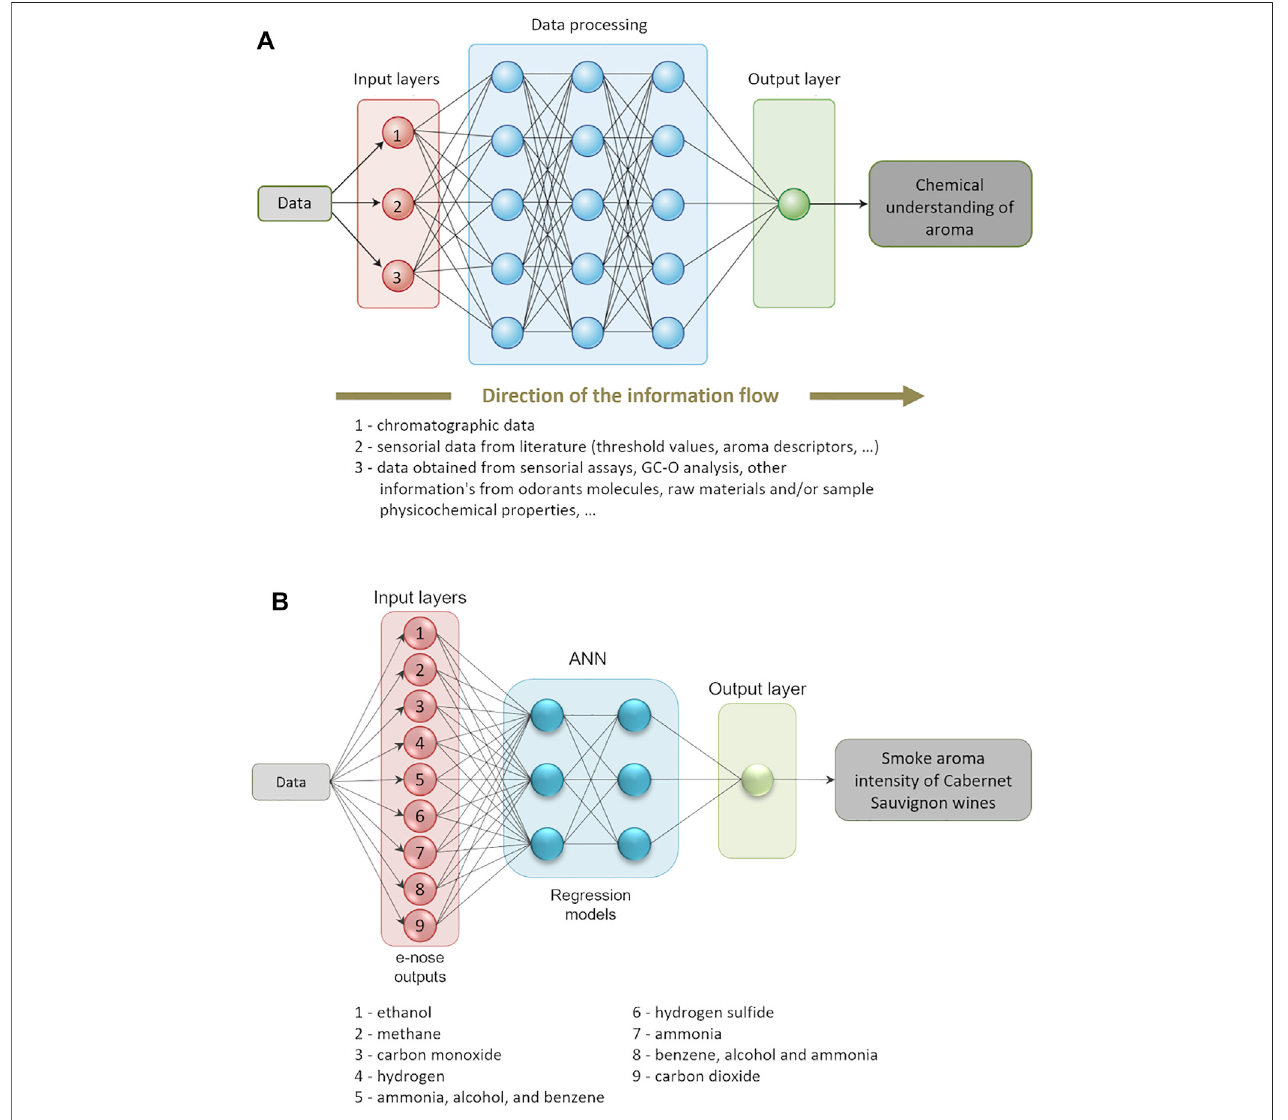
FIGURE 11 | (A) A symbiosis between advanced instrumental and bioinformatics with sensorial analysis or other data will represent a stream advance in chemical understanding of food aromas, taking advantage of the machine learning (ML) principles. Figure adapted from Topol (2019). (B) Assessment of volatile compounds in smoke-tainted Cabernet Sauvignon wines using a low-cost e-nose and machine learning modeling. The high accuracy regression models were constructed using e-nose outputs as inputs to predict smoke aroma intensity of Cabernet Sauvignon wines. ANN — arti fi cial neural network. Figure adapted from Summerson et al.